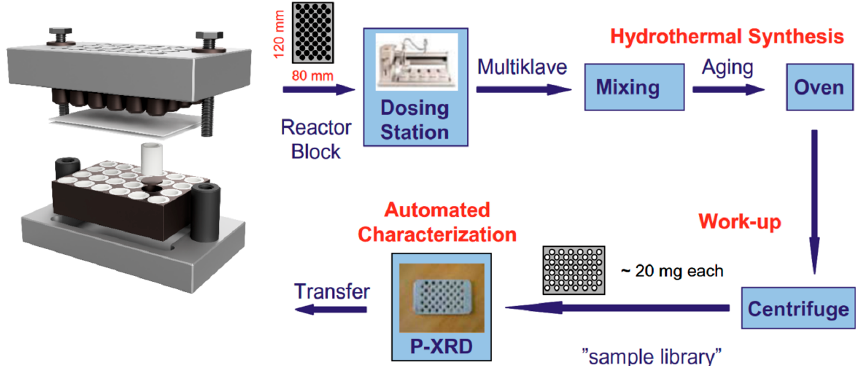
Figure 7. Typical workflow for a high-throughput (HT) synthesis experiment. Adapted with permission from reference [38]. Copyright 2009, Elsevier Inc.